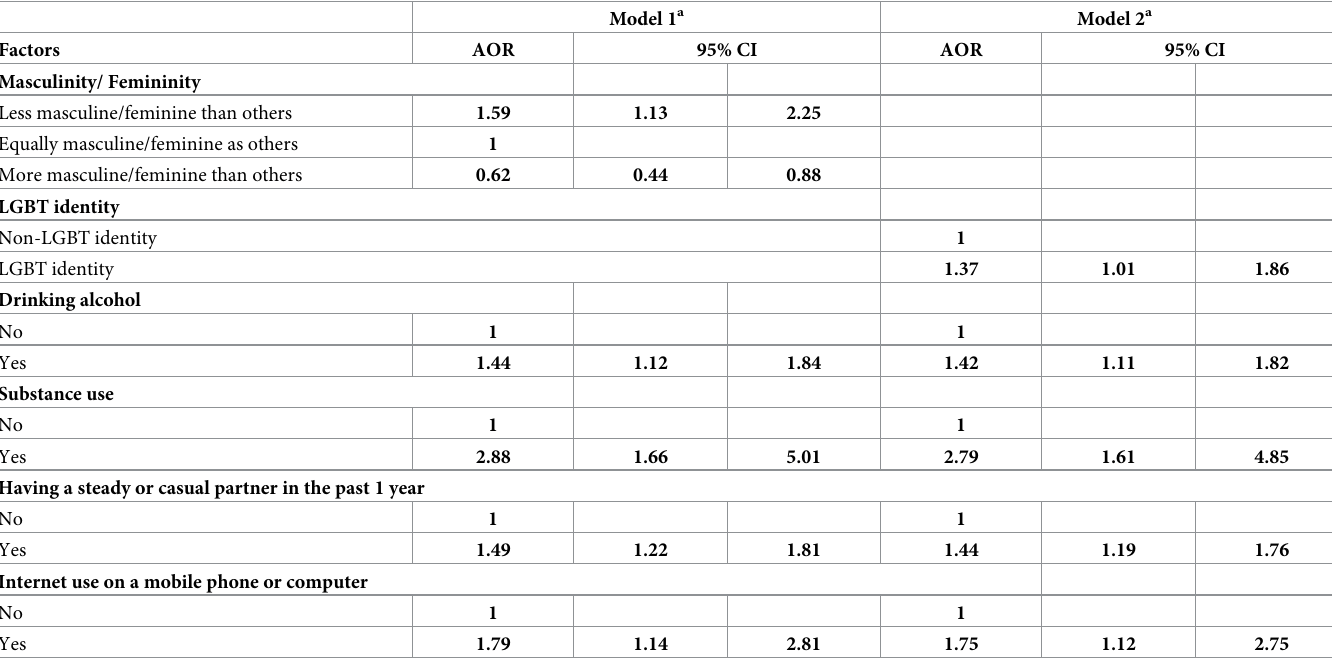
Table 3. Factors associated with social violence (N = 1848).